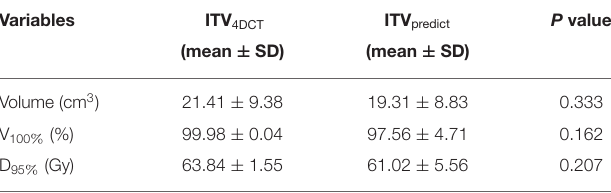
TABLE 4 | Calculated prescription dose coverage (V 100 ) and dose to 95% (D 95 ) of ITV.